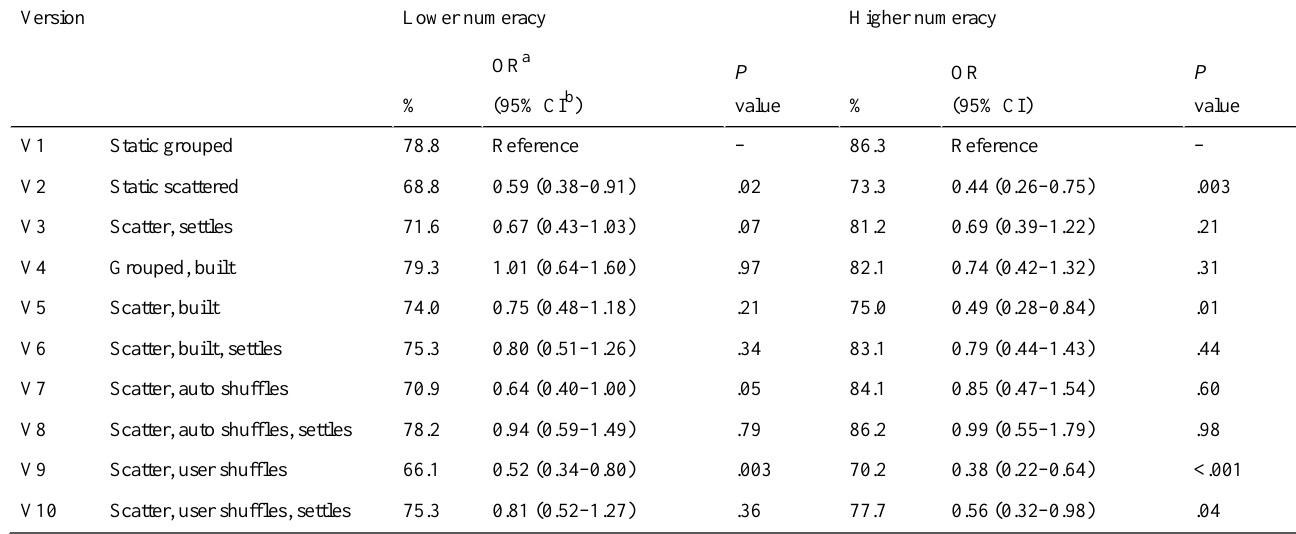
Table 4. Percentage correctly identifying that both treatments had an equal risk of fatigue, by graph version and respondent numeracy.